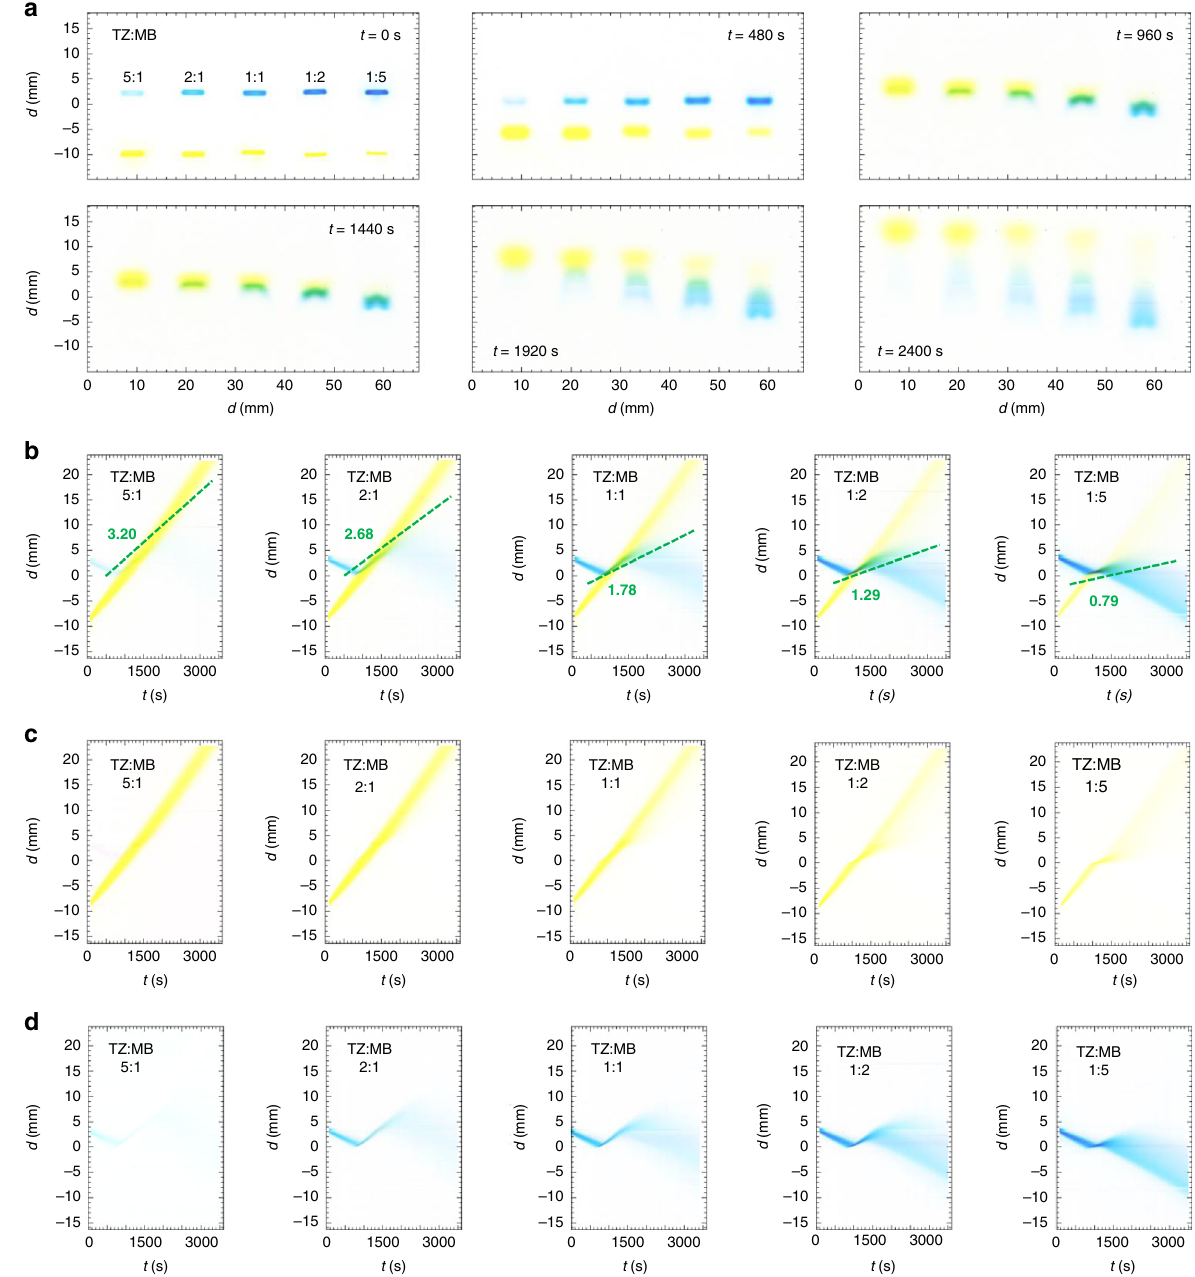
Fig. 5 Concentration dependence of band collisions between complexing dyes that have different charge magnitudes using BCGE. Conditions: same as in Fig. 3. Separation between the two wells: L = 12 mm. Shown for dyes TZ( − 3 e , lower yellow bands) and MB( + e , upper blue bands): a background- subtracted overhead images at times t = 0, 480, 960, 1440, 1920, and 2400 s after turning on E . Upper left: lanes are marked according to concentration ratio TZ:MB at a fi xed total concentration of 9.0 mM. b Space – time plots showing band trajectories of both TZ and MB. Offset green dashed lines: average trajectories of complexes containing MB immediately after collision; electrophoretic mobilities of these complexes μ e,meas (green numbers) in units of 10 − 8 m 2 V − 1 s − 1 . Separation of color channels yields an optical absorption space – time plot of: c only TZ; and d only MB. The x -direction points downward in all an invisible pulse of H 3 O + with a 4.5 mM counter-propagating band becomes singly protonated, revealing its yellow form band of BPB, which serves as a pH-dependent color indicator dye, (Fig. 7b, inset). Following this, a narrow faster-propagating plume at two different high H 3 O + concentrations, 0.5 and 0.25 M of blue BPB is ejected, strikingly, in front of the rest of the band (Fig. 7b, c, respectively). These concentrated acidic pulses tem- immediately after the protonated BPB returns to a deprotonated porarily overcome the 5.0 mM SBB locally, but the H 3 O + gra- state (Fig. 7c, inset). A space – time plot of the collision between dually becomes neutralized since the surrounding buffer has 0.5 M H 3 O + and 4.5 mM BPB (see Supplementary Movie 10, middle lane) reveals several stages associated with different BPB much greater volume, so these acid pulses become weaker over propagation velocities (Fig. 7b). At the onset of collision, time. Upon collision, initially only the leading edge of the BPB